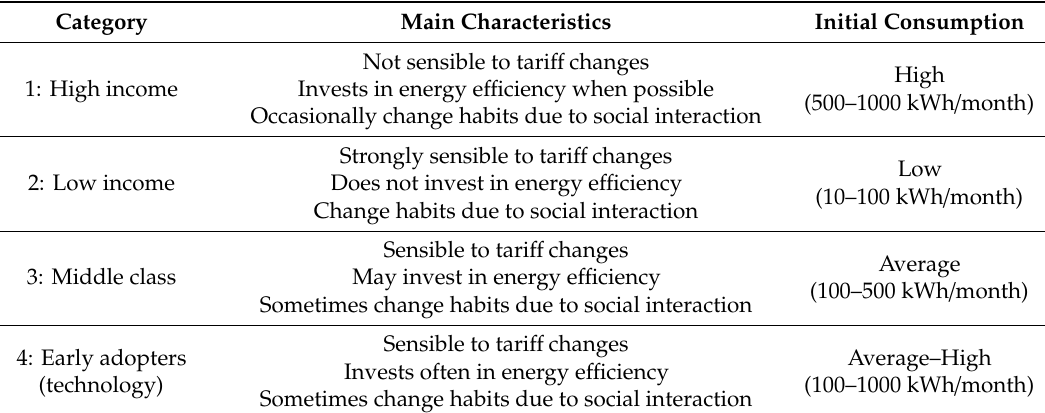
Table 1. Categories of consumers